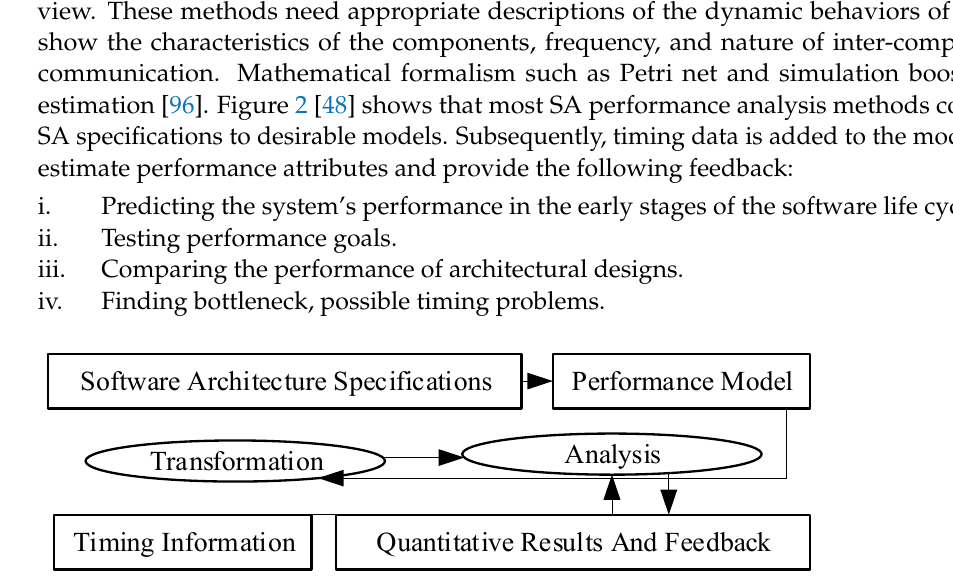
Figure 2. Software architecture ‐ based performance analysis.